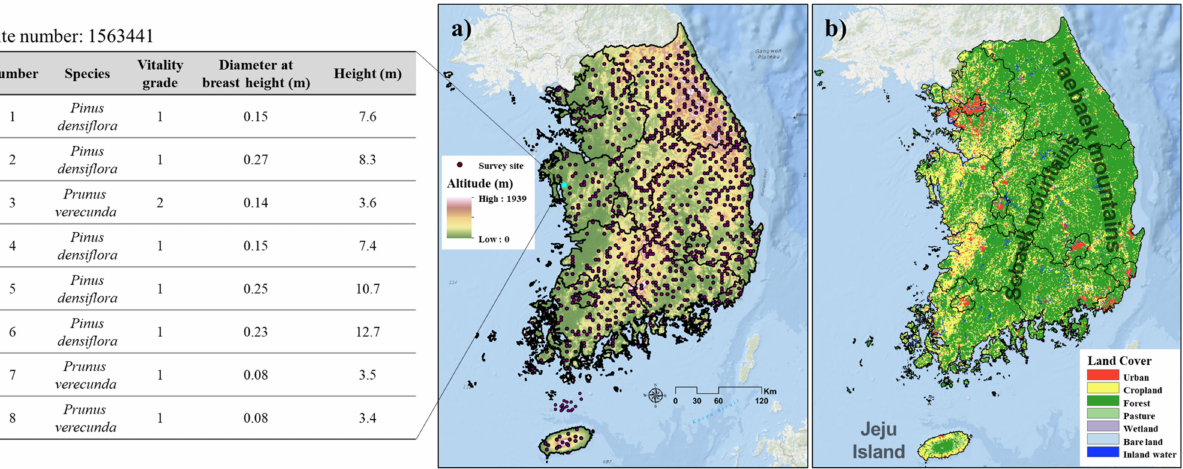
Figure 1. Forest health monitoring surveys in the ROK: ( a ) Distribution of survey plots with an example information of tree vitality in FHM; ( b ) land cover map of the ROK, produced in 2007 by the Ministry of